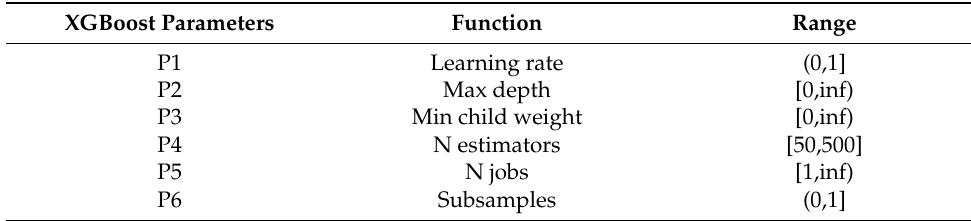
Table 3. XGBoost parameters.